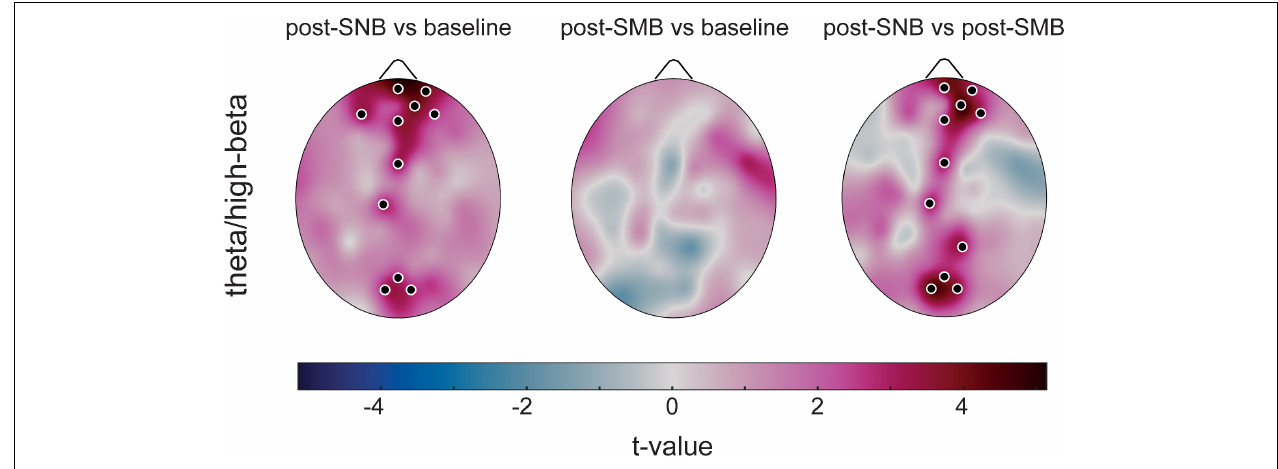
FIGURE 4 | Phase-amplitude coupling (theta/high-beta) increases in DMN regions after SNB. Electrode-wise between-phase differences are presented for each between-phase comparison ( t -values maps). Significant comparisons (former phase > latter phase) are denoted by black